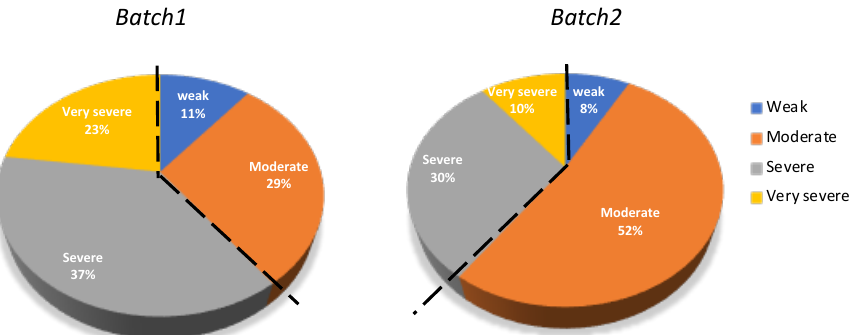
Figure 3. Severity index (SI) categories in batch 1 and batch 2. The percentages for the four categories are indicated. The dashed line indicates the binary classifaction as low (weak and moderate) and high (severe and very severe) susceptible fish.